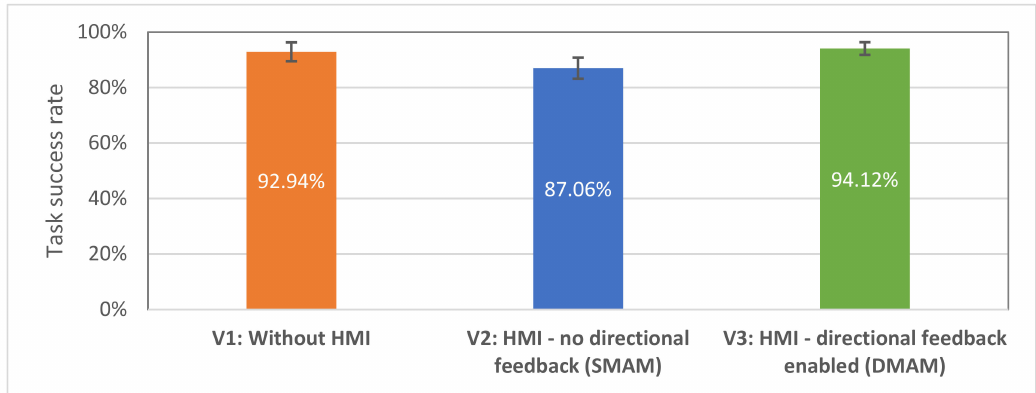
Figure 17. Average task success rate for all 17 participants: higher is better.